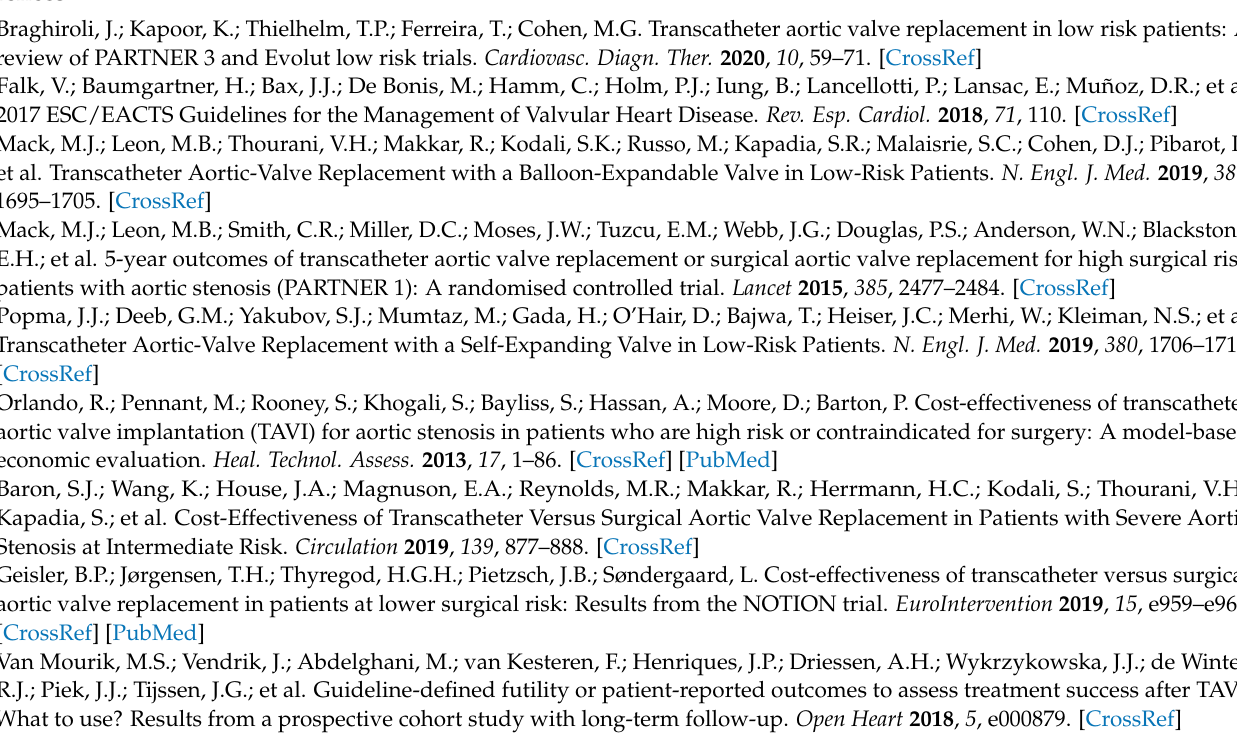
Supplementary Table S3: Multivariate Cox regression analyses of futile events based on patients’ VARC-2 adverse